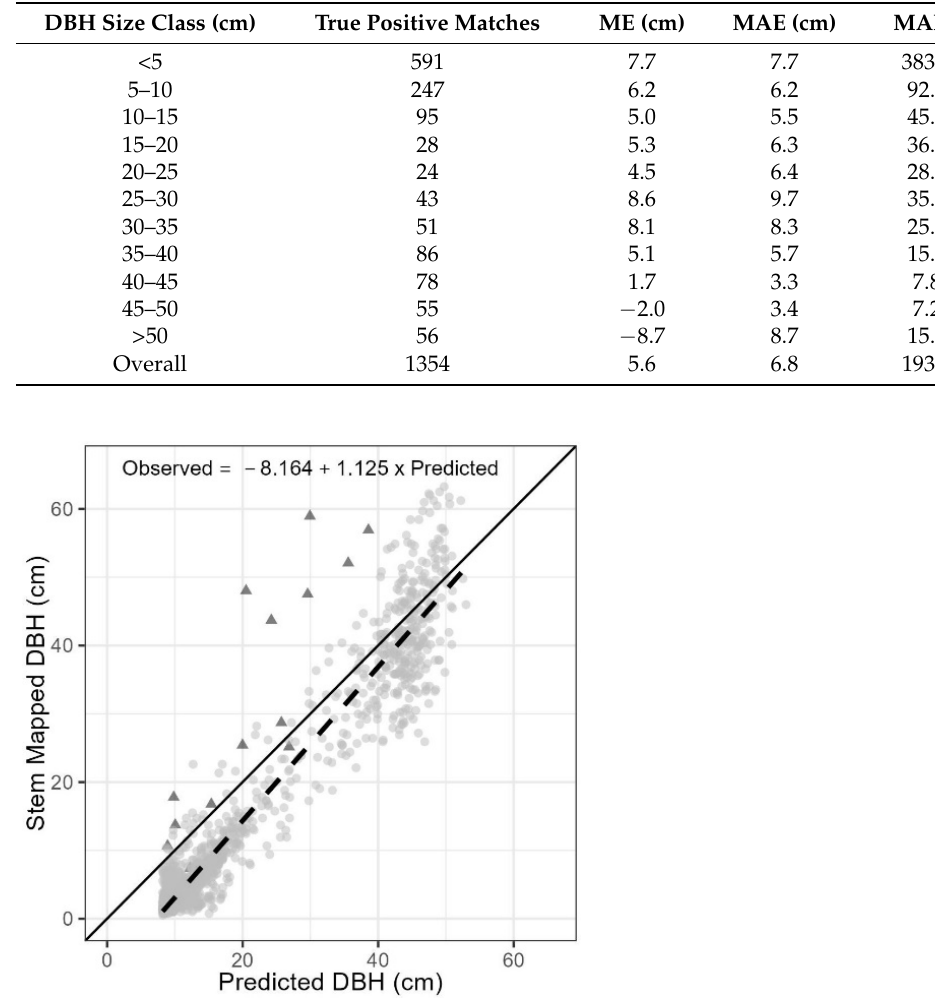
Figure 5. Stem mapped vs. best SfM predicted DBH values. Trees marked with triangles were recorded as having broken or missing tops in the field. A simple linear regression (dashed line) through all data points is provided for comparison to the 1:1 line (solid).